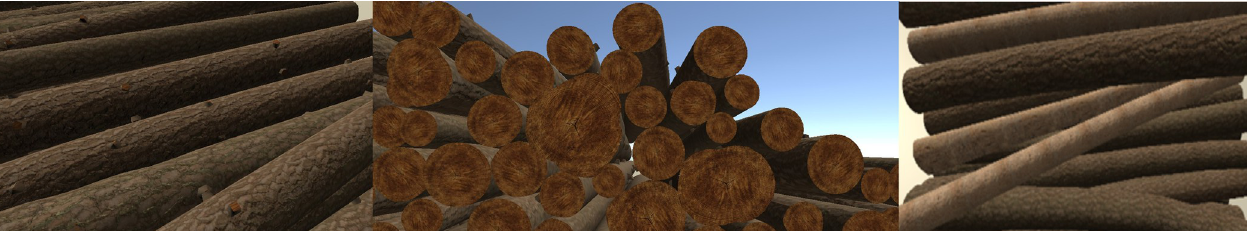
PLOS ONE | https://doi.org/10.1371/journal.pone.0264414 March 16,